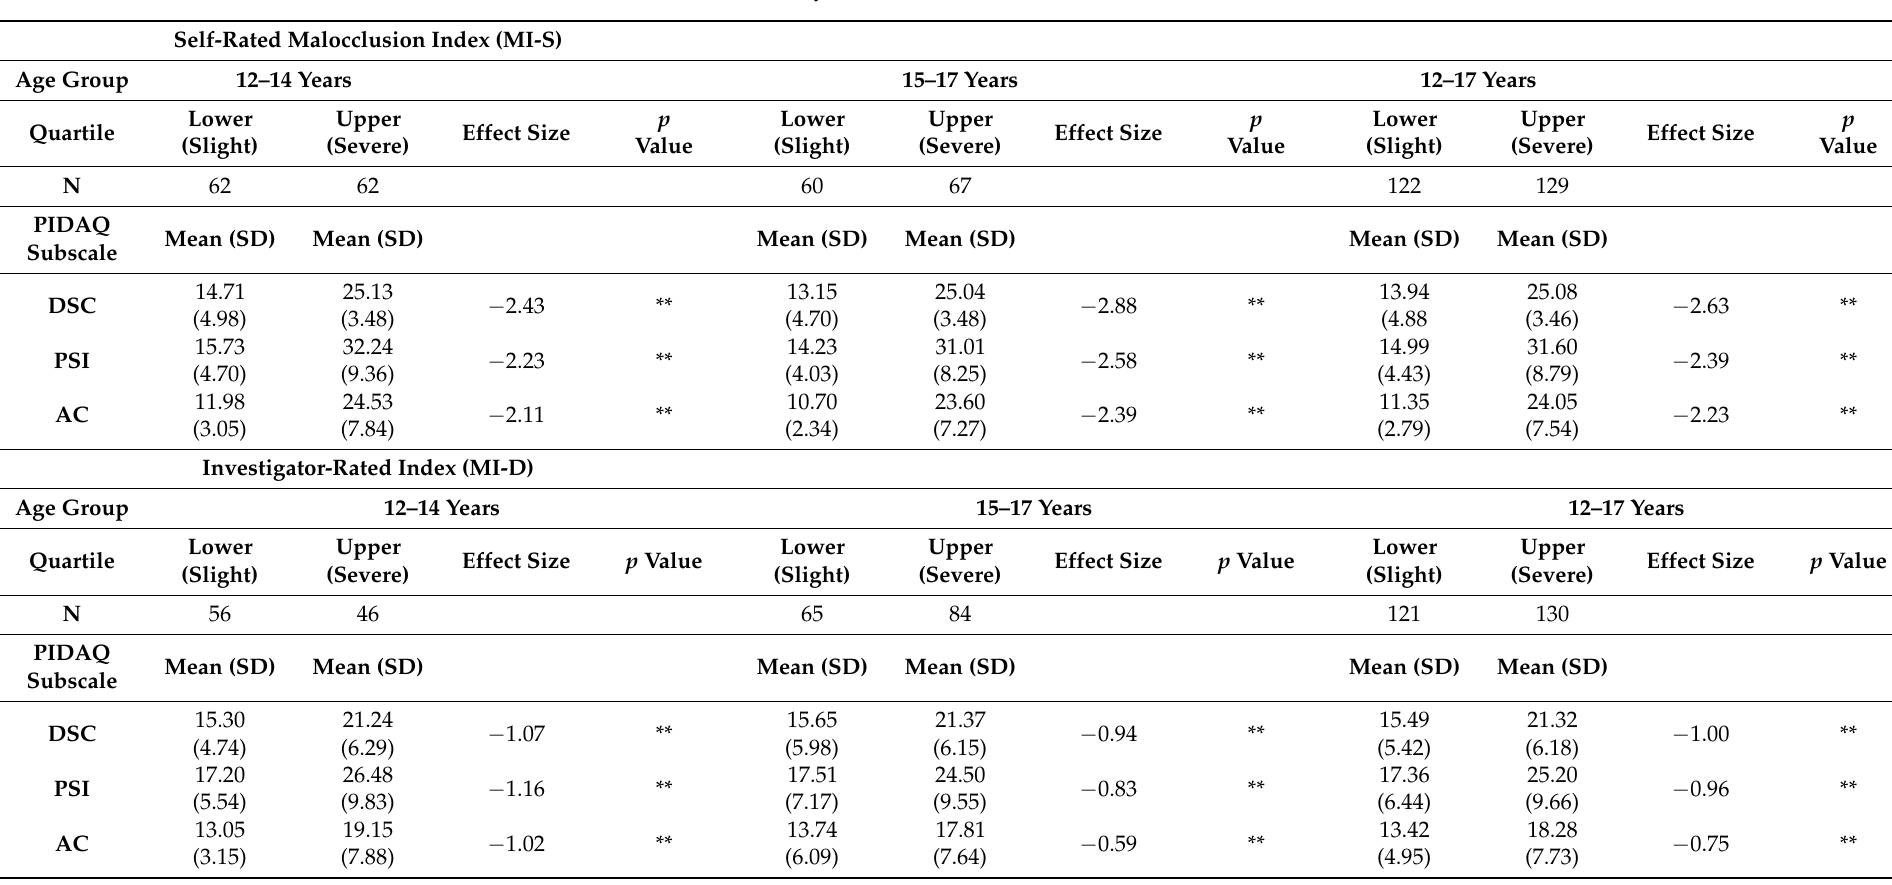
Table 8. Discriminant validity: association between the PIDAQ(A) and MI-S and